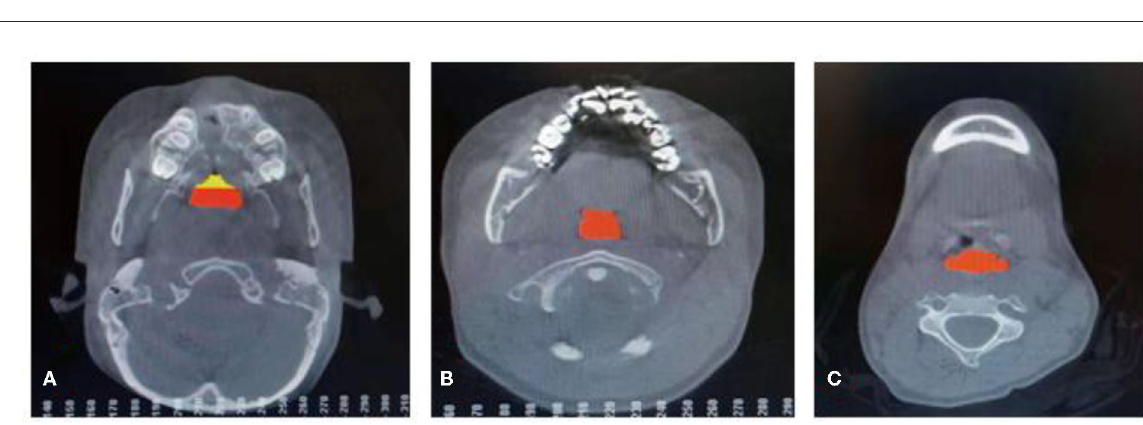
were higher than the control ones. In addition, the control group’s measurements, including the cross-sectional area, the minimum cross-sectional area of the airway, and the airway area at the tongue level, were significantly larger than in the experimental group. It was noted that there was no significant difference in the horizontal cross-sectional area of the hard palate and the horizontal cross-sectional area of the soft palate between the experimental and control groups. Therefore, the measurements, including the distance between the hard palate and the soft palate, are statistically significant between the two groups. The detailed information is presented in Table 1, and the comparison between the unilateral complete cleft lip and palate group and the control group is shown